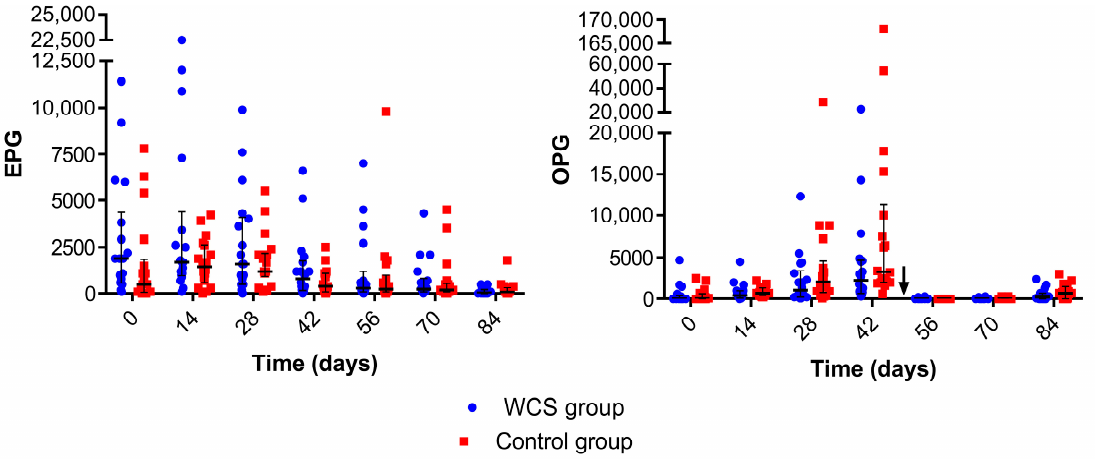
Figure 1. Median (interquartile range) of eggs per gram of feces (EPG) and Eimeria spp. oocysts per gram of feces (OPG) of crossbred lambs naturally infected with gastrointestinal parasites and receiving two different diets (whole cottonseed and control) at seven different samplings (0–84 days). There was an interval of 14 days between each sample collection. The arrow indicates the treatment with 5% toltrazuril.